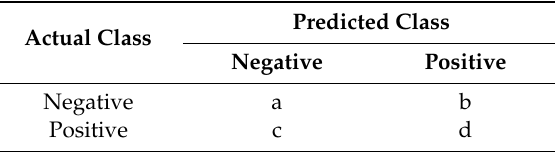
Table 4. Confusion matrix of size 2 ×